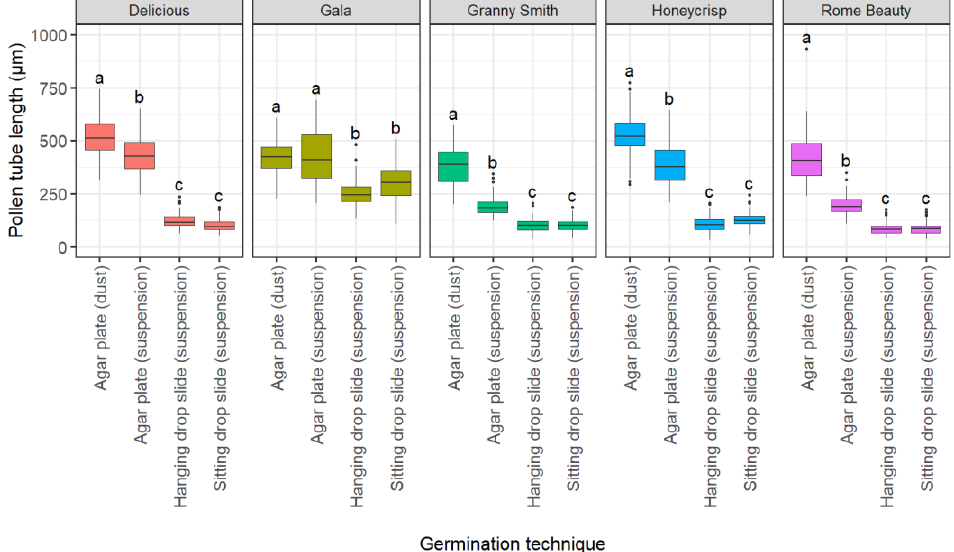
Figure 3. Effect of germination technique on in vitro pollen tube length of ‘Delicious’, ‘Gala’, ‘Granny Smith’, ‘Honeycrisp’, and ‘Rome Beauty’. Different letters indicate significant differences among germination techniques within cultivars based on Fischer’s LSD test ( p < 0.05).